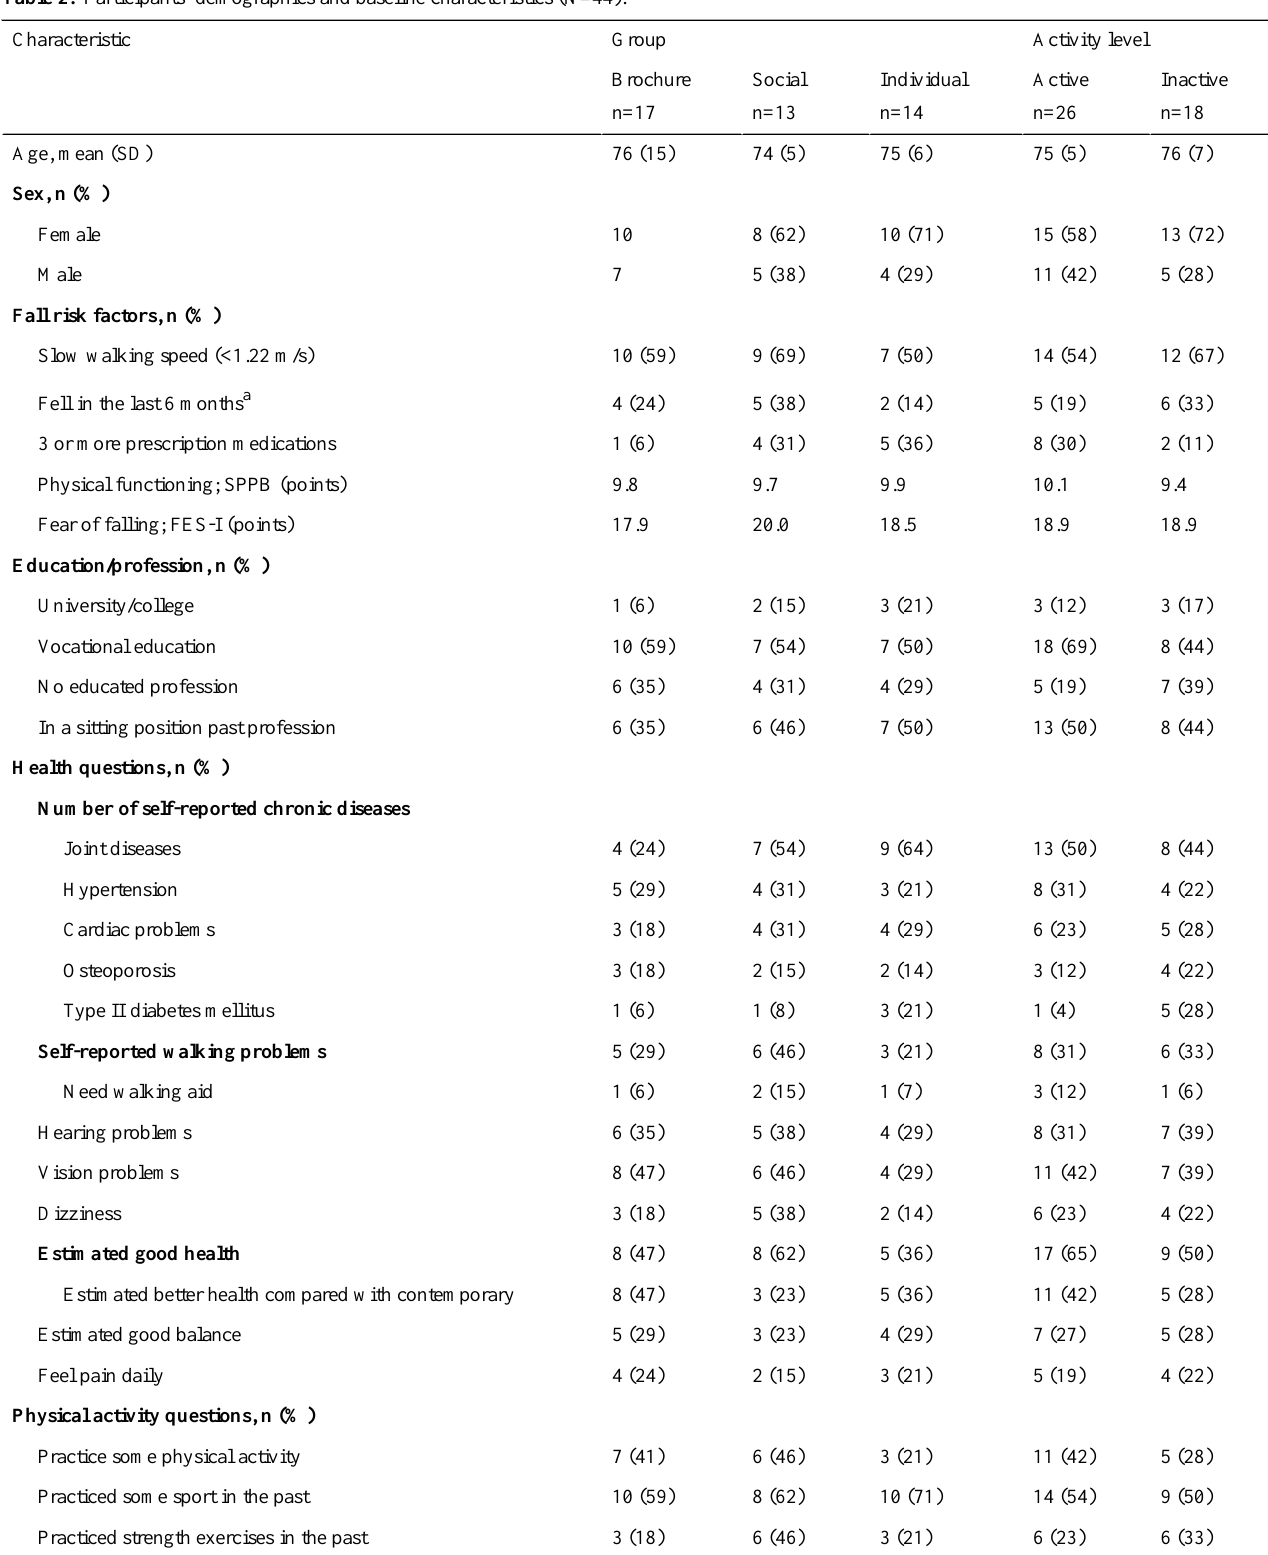
Table 2. Participants’demographics and baseline characteristics (N=44).